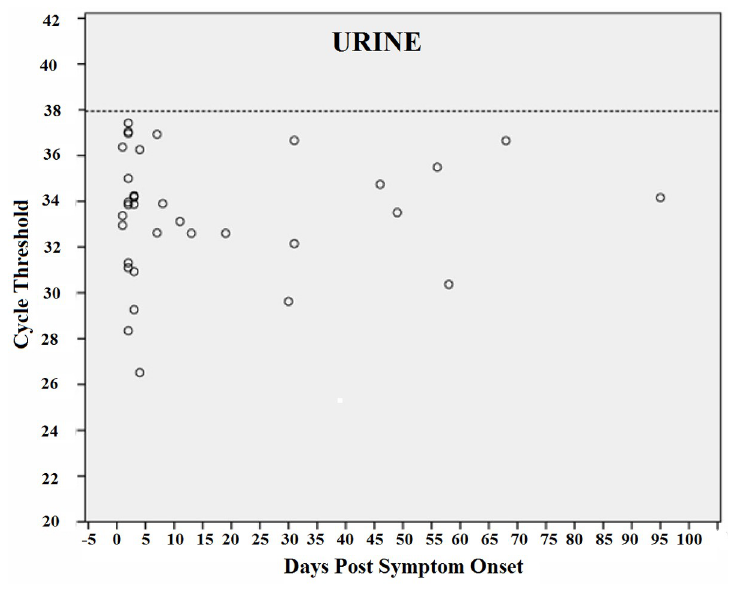
Fig 7. CHIKV Cycle Threshold (Ct) by days after the onset of symptoms in Urine.